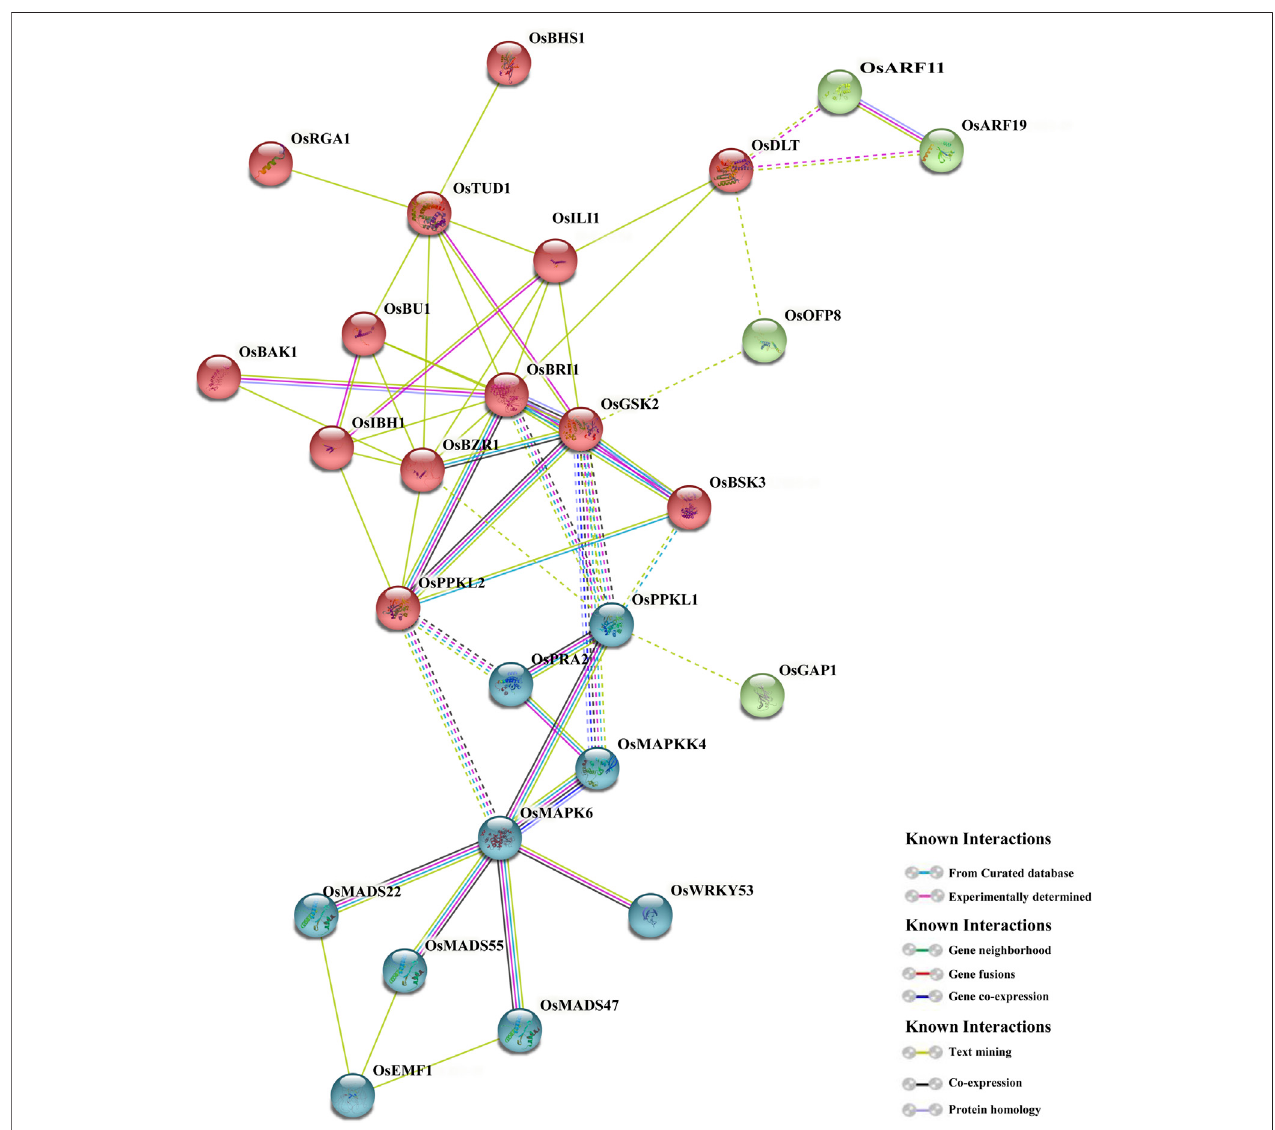
FIGURE 9 | Protein-protein interactions among the BR signaling components in